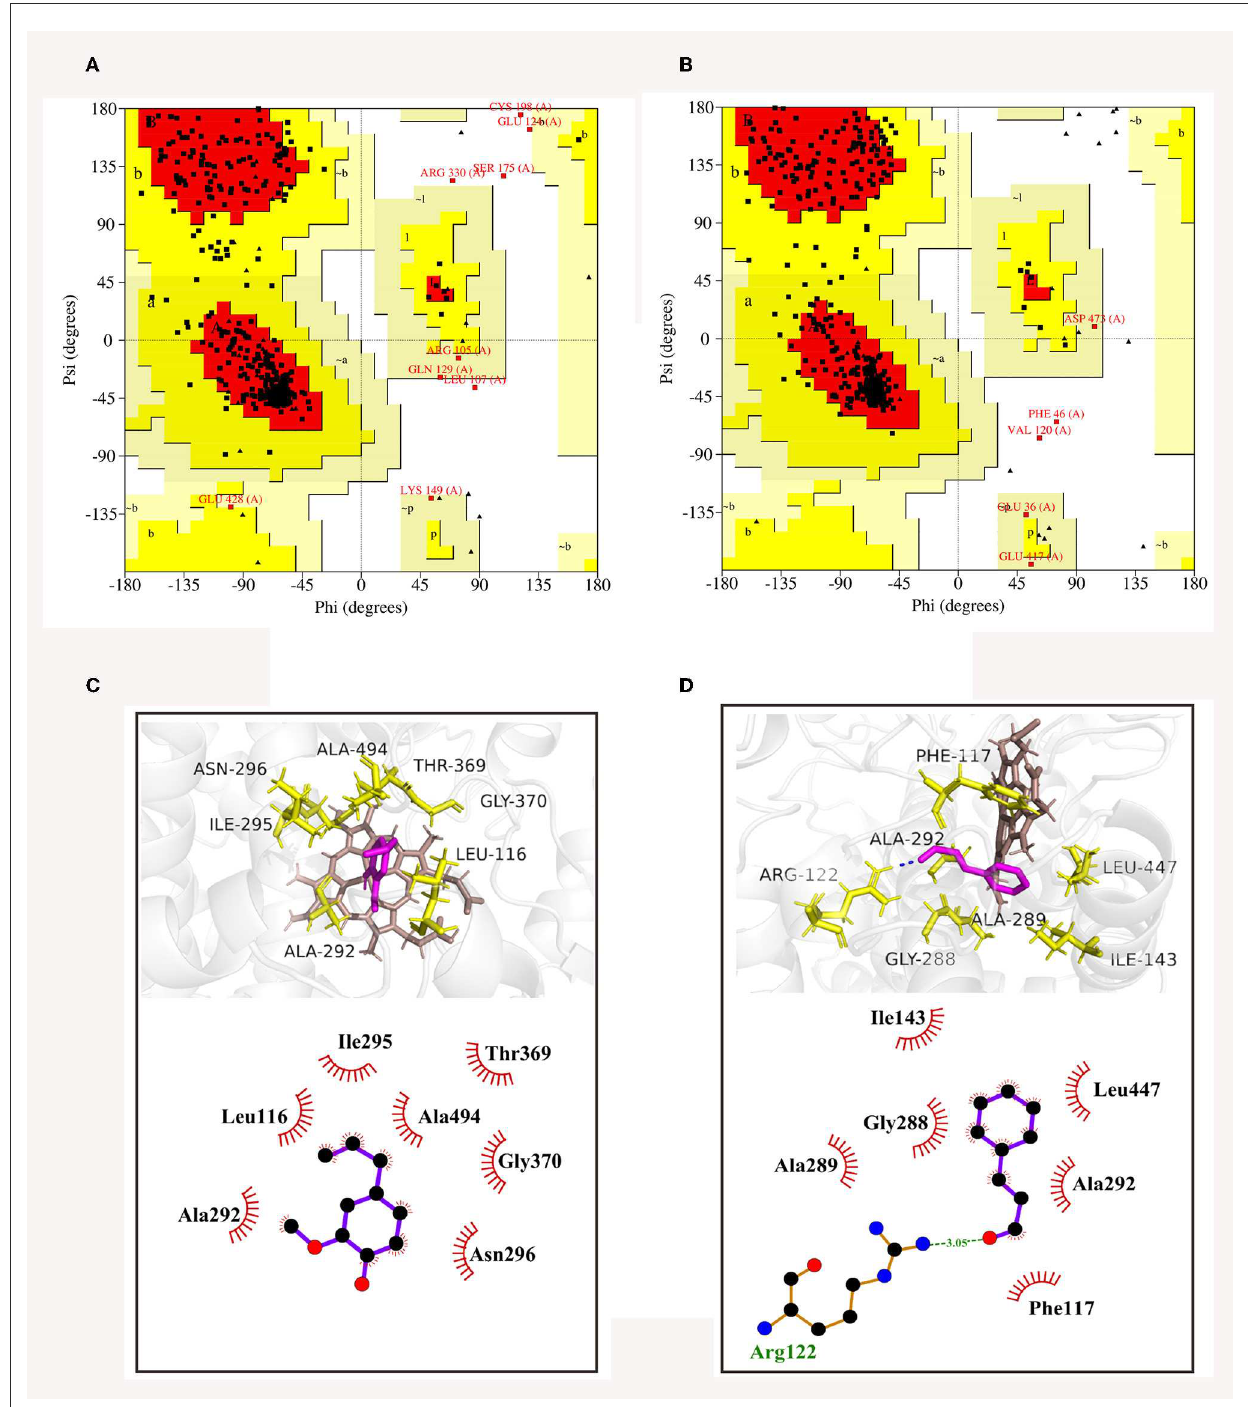
FIGURE9 Ramachandran plots of CYP51 of C. gloeosporioides (A) and B. dothidea (B) , as well as the 3D and 2D diagrams of docked modes of CYP51 with trans -cinnamaldehyde (C) and eugenol (D) .